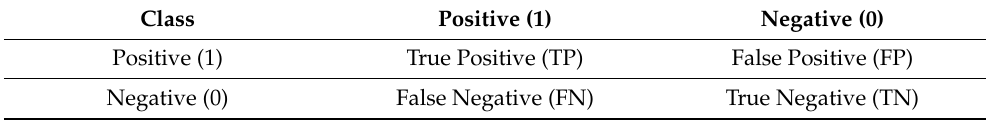
Table 5. Confusion matrix of classification.